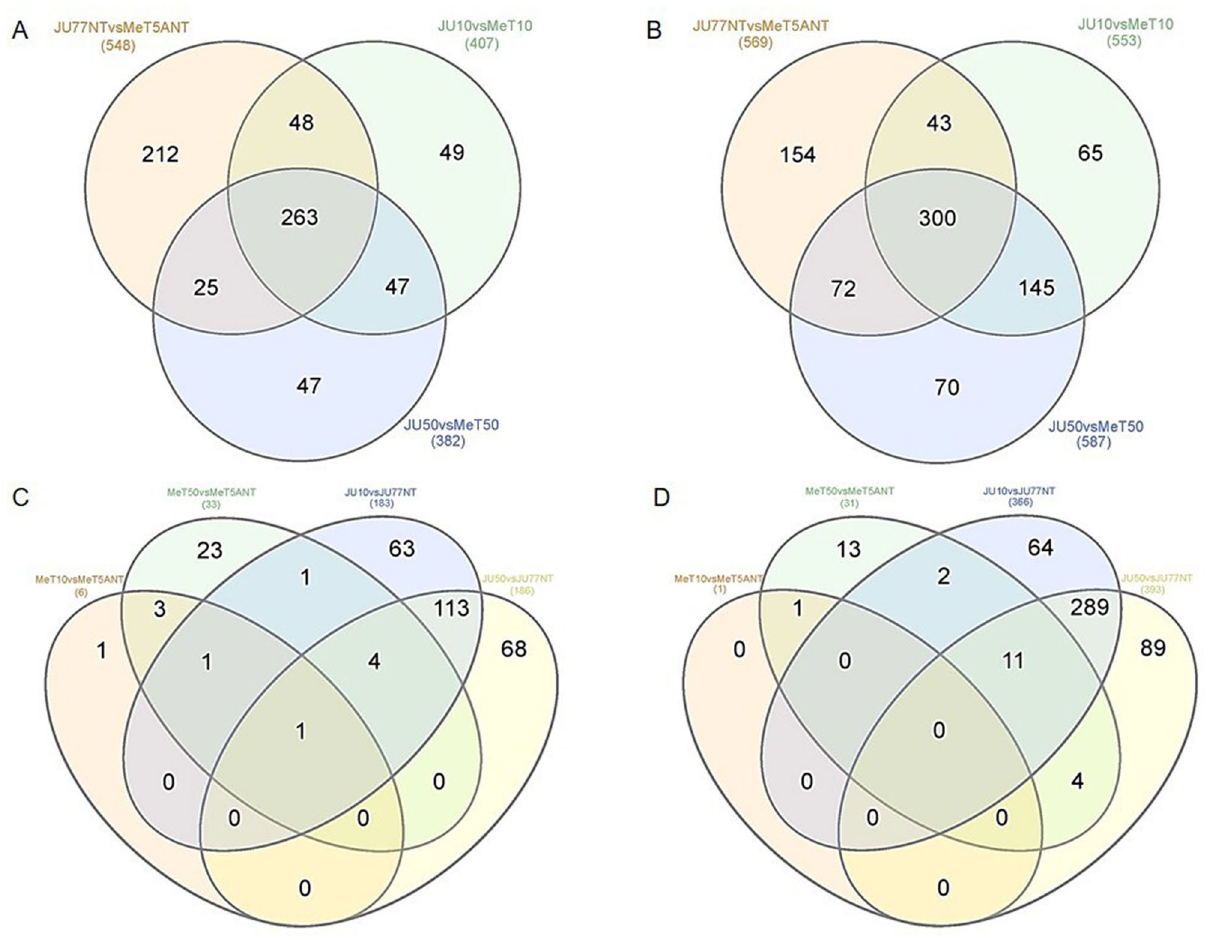
Figure 4. Venn diagrams showing down-regulated miRNAs and tRNA-derived ncRNAs distribution between: ( A ) JU77 vs. MeT-5A cell lines both not exposed and exposed to FE fibers; ( C ) The same cellular line both not exposed and exposed to FE fibers. Venn diagrams showing up-regulated miRNAs and tRNA-derived ncRNAs distribution between: ( B ) JU77 vs. MeT-5A cell lines both not exposed and exposed to FE fibers; ( D ) The same cellular line both not exposed and exposed to FE